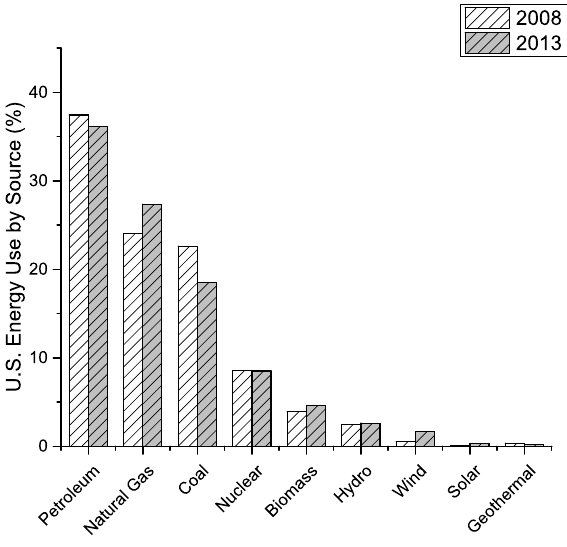
Figure 1. U.S. Energy Use